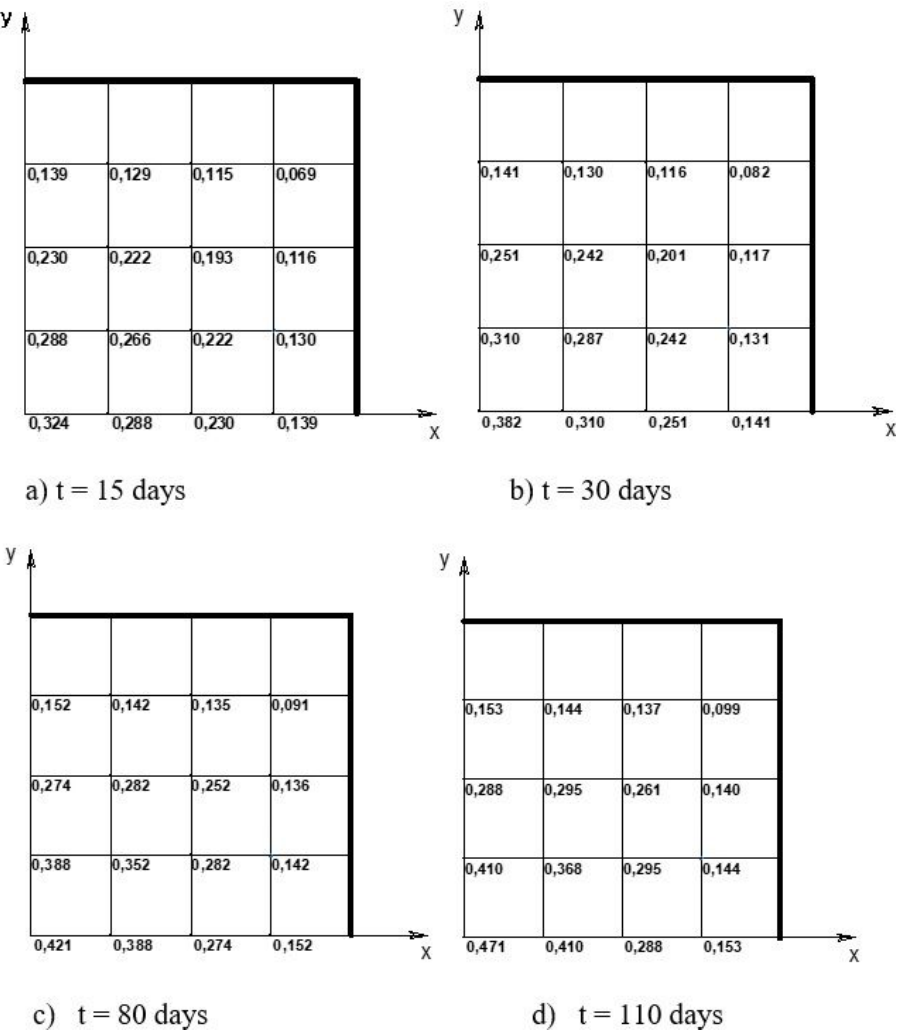
Figure 4: The growth of deflection (cm) in sections of the shell in the calculated time intervals